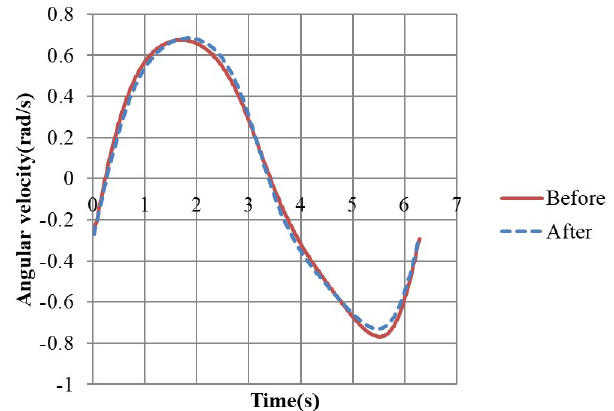
Figure 16. The angular velocity ω 4 of the driver side output-link of CDLS before/after DE opti- mization.